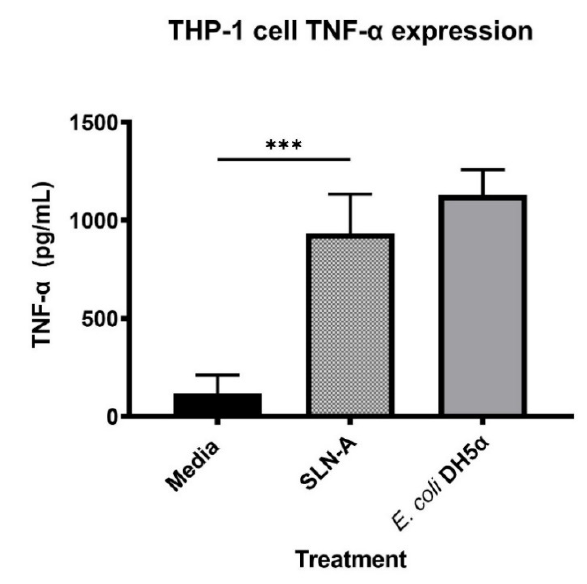
Figure 4. Expression of tumor necrosis factor alpha (TNF- α ) by THP-1 cells stimulated with SLN-A particles. One-way ANOVA confirmed that a significant difference in TNF- α expression was observed between cells treated with media and cells treated with SLN-A (F(2,6) = 39.35, P = 0.0009). *** denotes P ≤ 0.001.